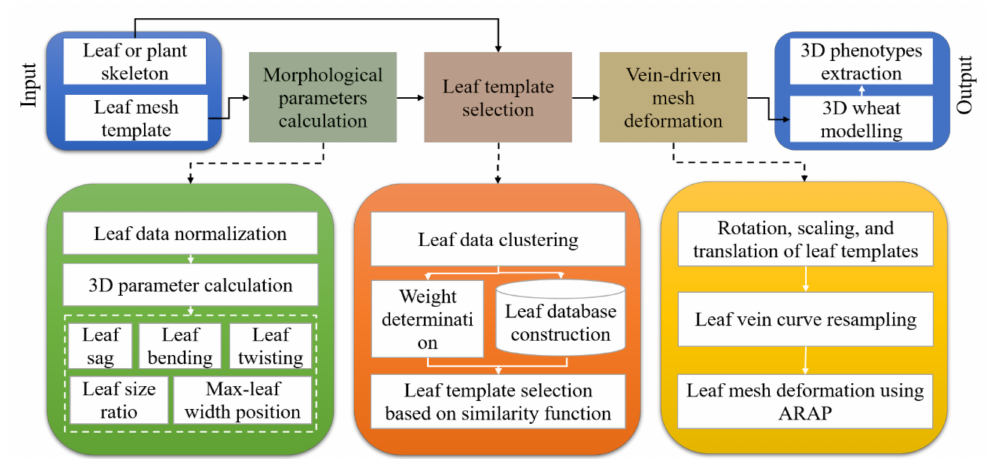
Figure 2. Overall flow chart of wheat 3D modelling